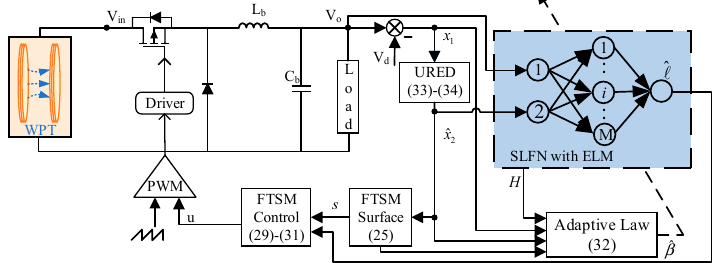
Figure 2. Control diagram of the proposed control scheme.